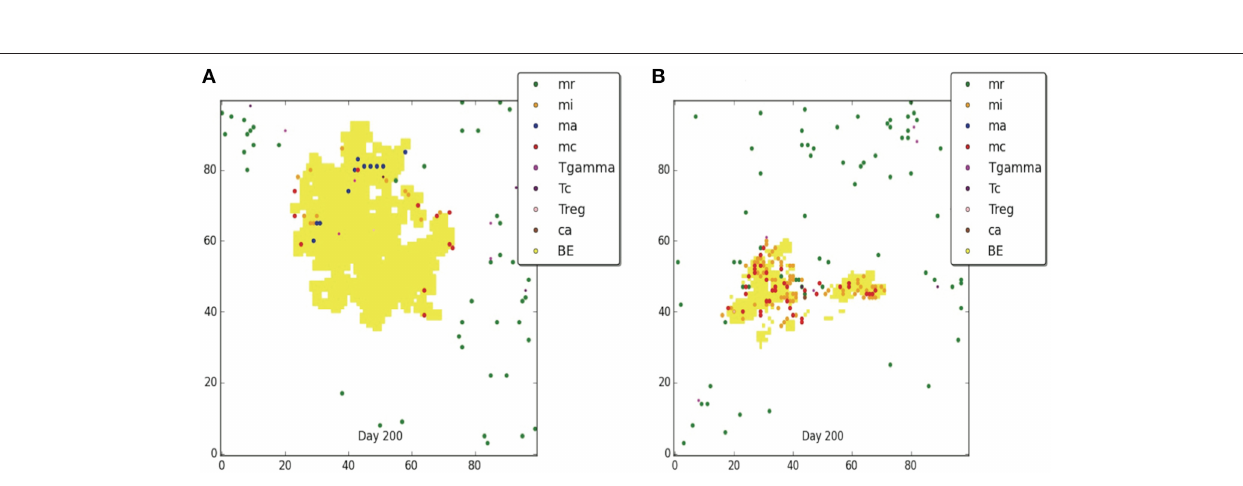
Frontiers in Cellular and Infection Microbiology |